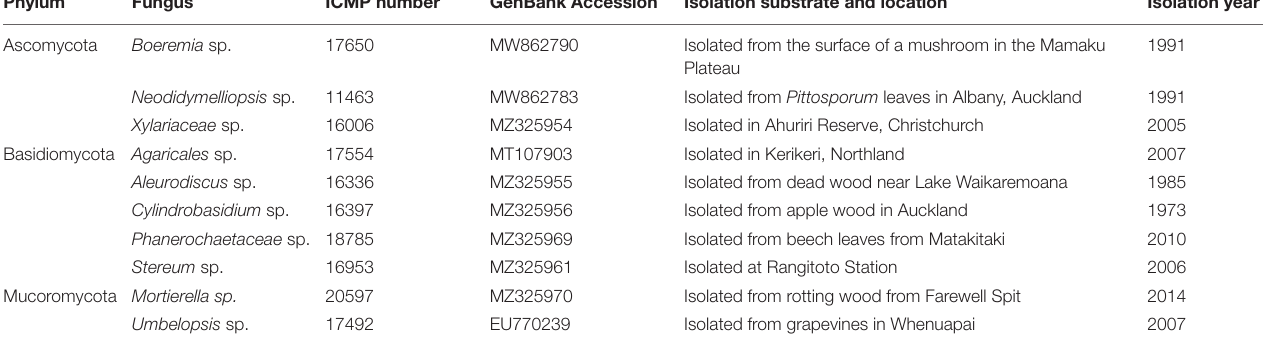
TABLE 2 | ICMP isolates belonging to novel fungal taxa likely endemic to Aotearoa New Zealand. Phylum